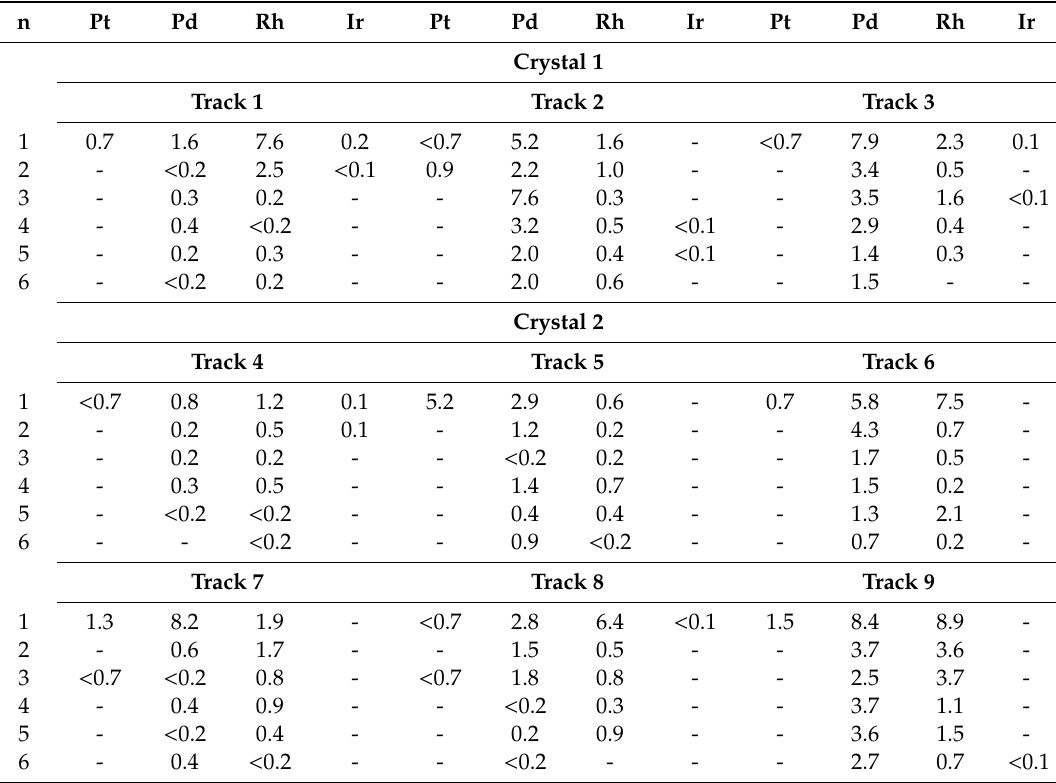
Figure 13. Pyrite Crystals 1 and 2 (sample UV-3/13) from ores of the Natalkinskoe deposit. Tracks 1–8, numbers of laser passes over the crystal surface. The results of LA-ICP-MS analysis are presented in Table 13. Table 12. Results of LA-ICP-MS analysis (in ppm) of the surface of arsenopyrite crystals (1 and 2) for Pt, Pd, Rh and Ir (sample UV-3 / 13) (the Natalkinskoe